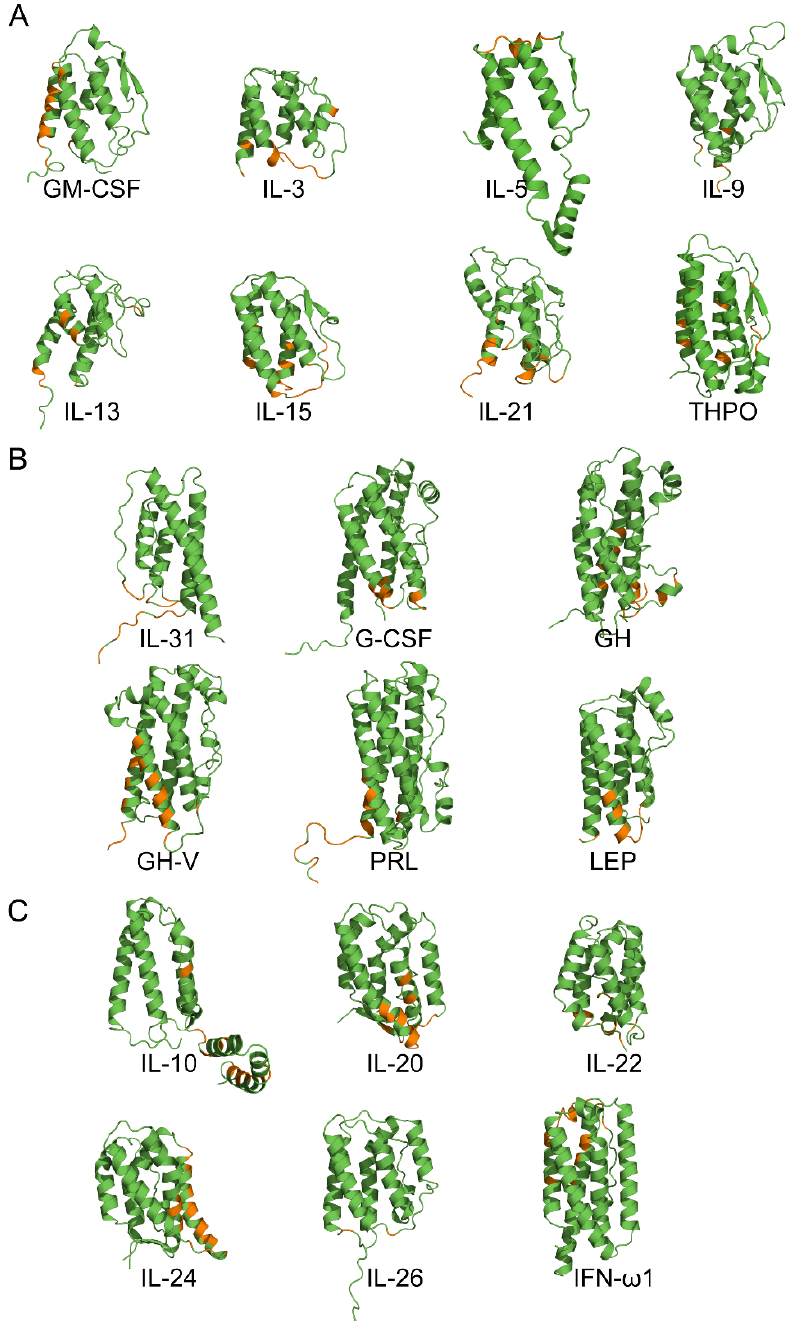
Figure 6. The tertiary structures of the four-helical cytokines of short-chain (panel A ), long-chain ( B ) and interferons/IL-10 ( C ) families (Table S3) used for the structural modeling of their complexes with Ca 2+ -loaded S100P dimer by ClusPro docking server [40] (only one subunit is shown for IL-5). The contact residues included in five or more docking models were considered as the most probable residues of the binding site (orange-colored). N -terminus is located in the lower-left corner for each cytokine.